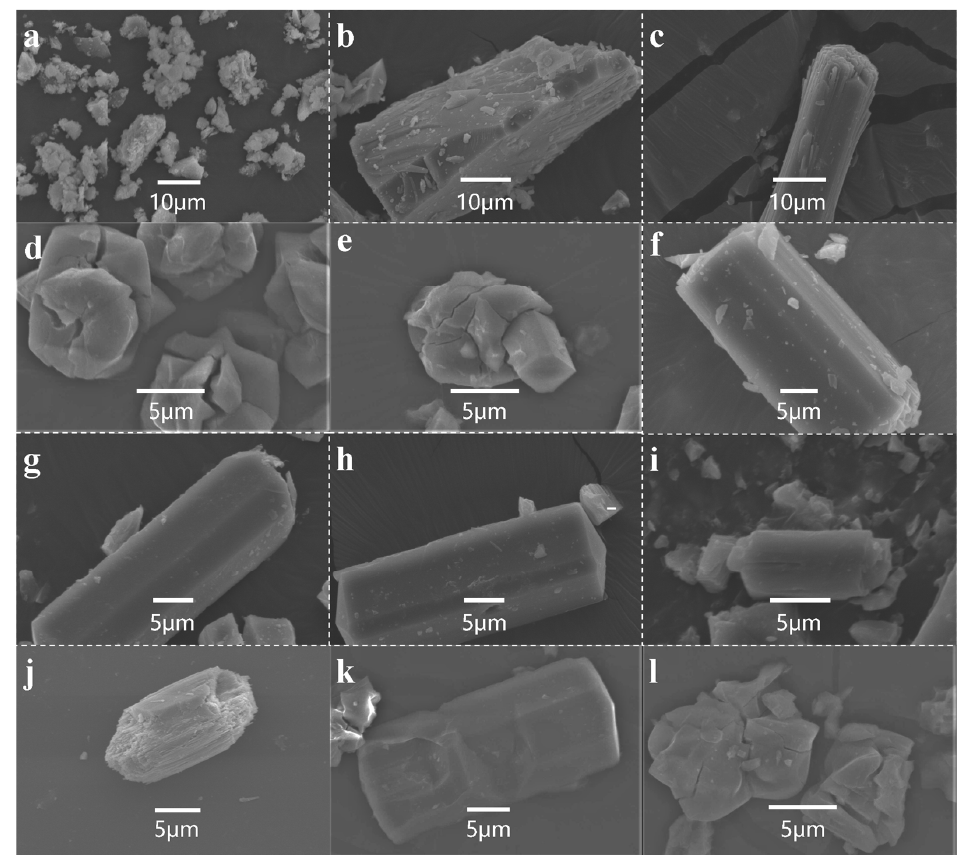
Figure 5. SEM images of IW–MOR samples that were crystallized for ( a ) 0 h, ( b ) 2 h, ( c ) 4 h, ( d ) 8 h, ( e ) 12 h, ( f ) 16 h, ( g ) 24 h, ( h ) 36 h, ( i ) 48 h; ( j ) T–MOR–24 sample; ( k ) IN–MOR–24–0.07 sample; and ( l ) IN–MOR–24–0.1 sample.